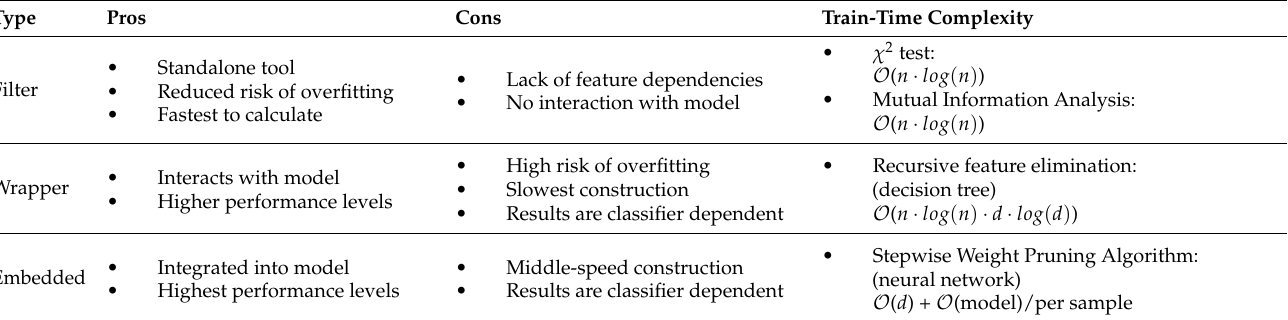
Table 1. Comparison of the FS method types [44] extended with